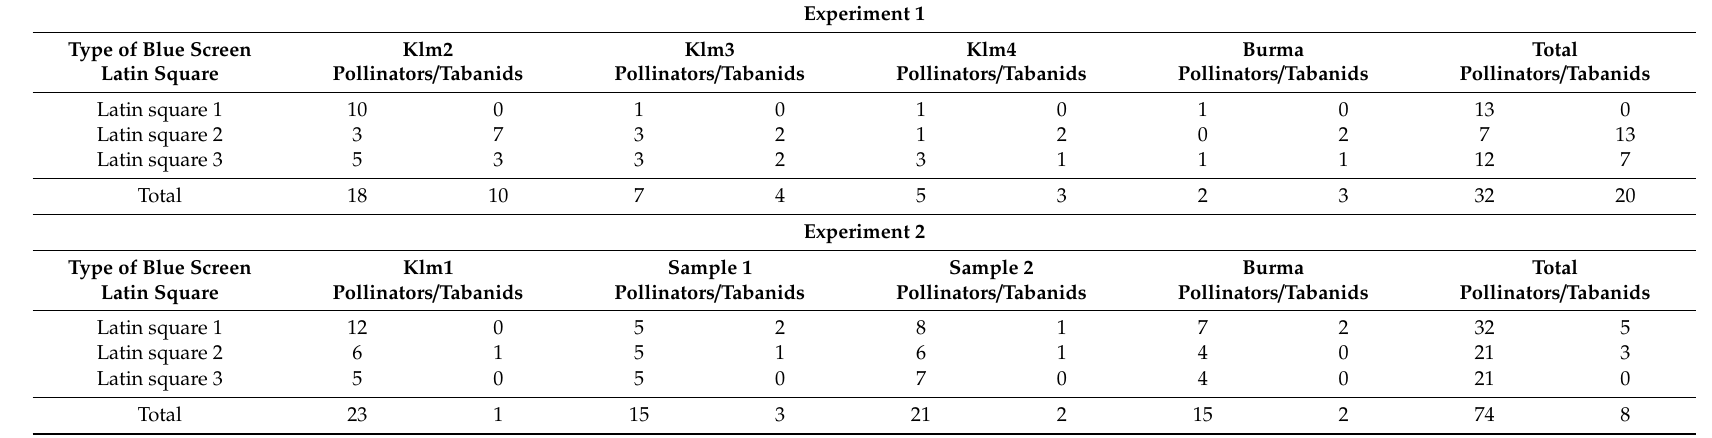
Table 2. Total numbers of pollinating insects (including bees and syrphids) and horse flies caught during three sessions of 4 days of trapping /